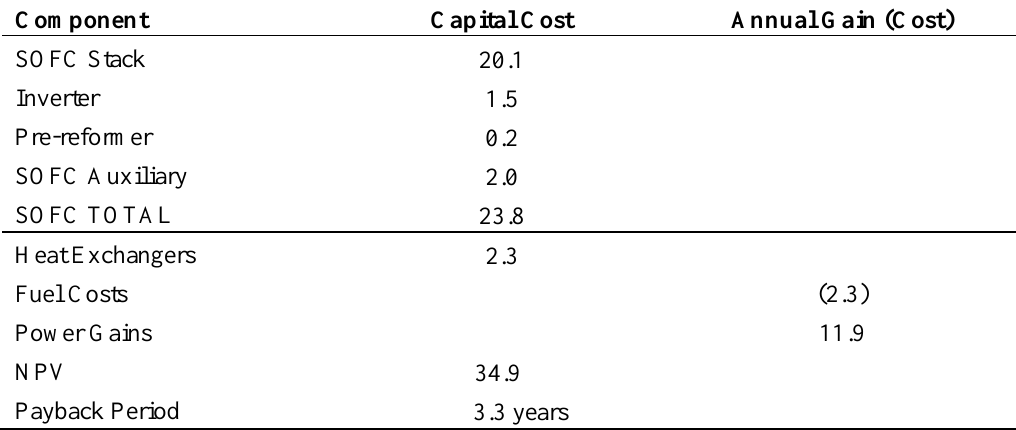
Table 3. Cost breakdown for the hybrid plant (USD